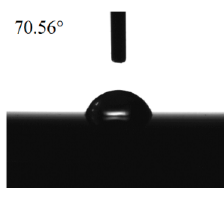
Figure 2. Schematic diagram of octadecyltrichlorosilane (OTS) self-assembly reaction